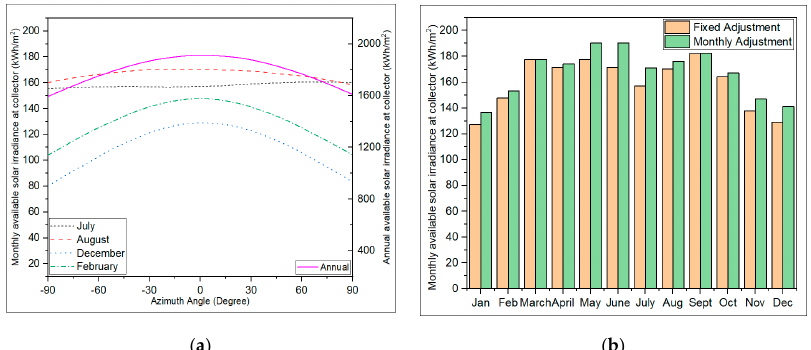
Figure 14. ( a ) Variation of solar irradiance as a function of collector orientation; ( b ) solar irradiance available at collector surface with fixed and monthly adjustment.